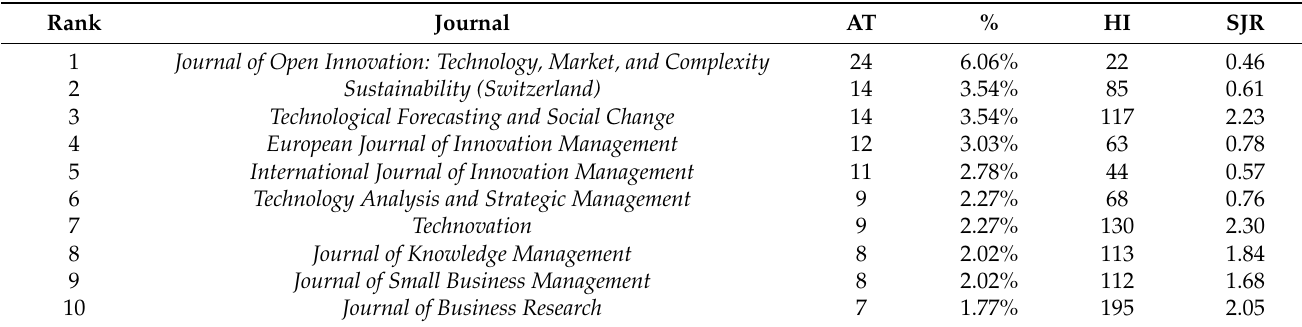
Table 2. Top 10 journals with the highest number of